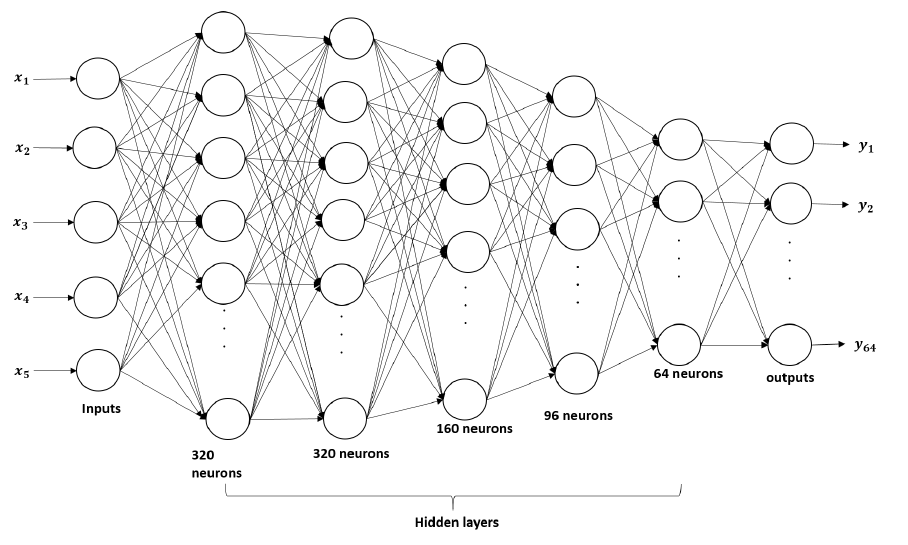
Figure 2. Five-layer Deep neural